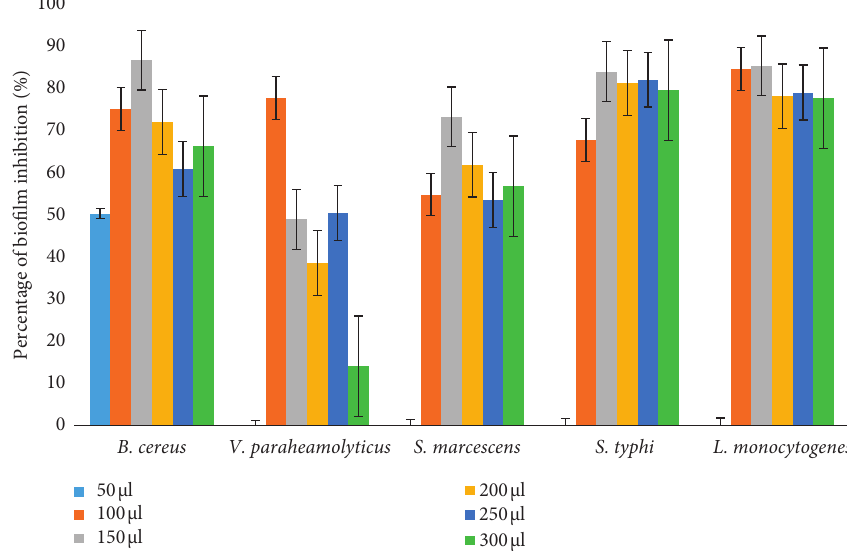
Figure 4: Percentage of biofilm inhibition against B. cereus , V. parahaemolyticus , S. marcescens , S. Typhi, and L. monocytogenes .